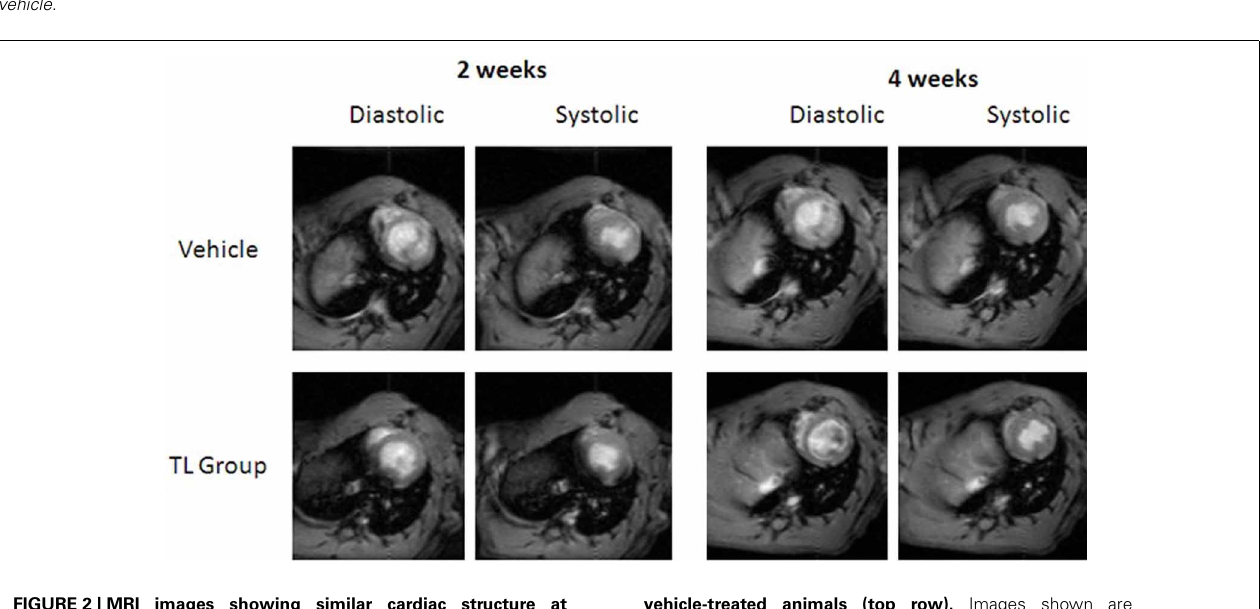
vehicle-treated animals (top row). Images shown are representative images taken from the same animals at the indicated time